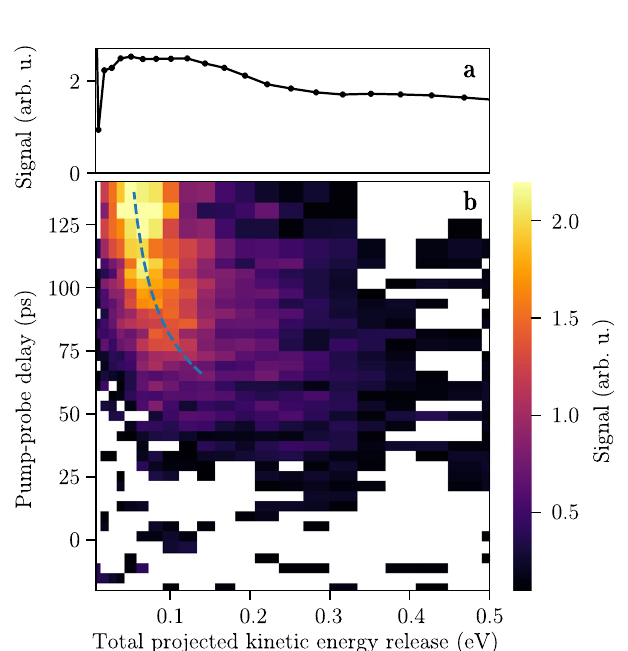
Fig. 1 | Time-dependent molecular signals and experimental setup. a Delay- dependent yields of (blue) indole(H 2 O) + , (red) indole + , and (green) H 2 O + . Symbols represent the experimental data whereas lines represent the simulated data based onourreactionmodel.Statistical1 σ errorestimatesaregivenbyverticallinesforall experimental data points. b Delay-dependent indole(H 2 O) + and indole + signals for short delays. c Illustration of the experimental setup, containing an electrostatic